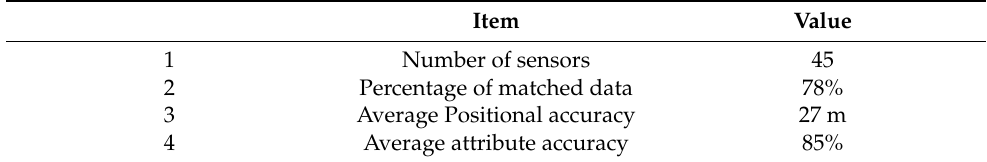
Table 3. The proposed method in real sensor data.